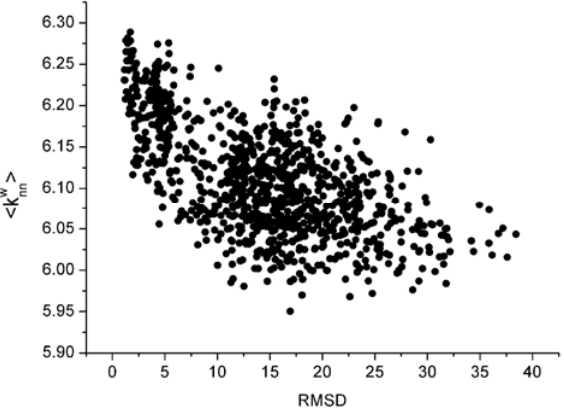
Figure 2. The relationship between the weighted average nearest neighbors’ degree and the L_RMSD (The 1udi was taken as an